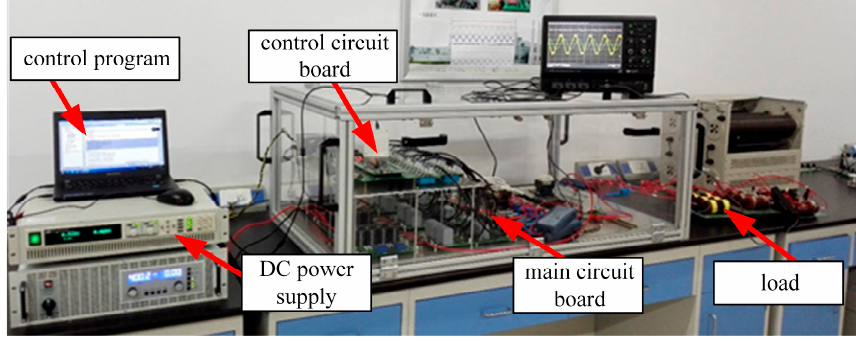
Figure 12. Scaled-down experimental platform of the proposed single-phase nine-level inverter.